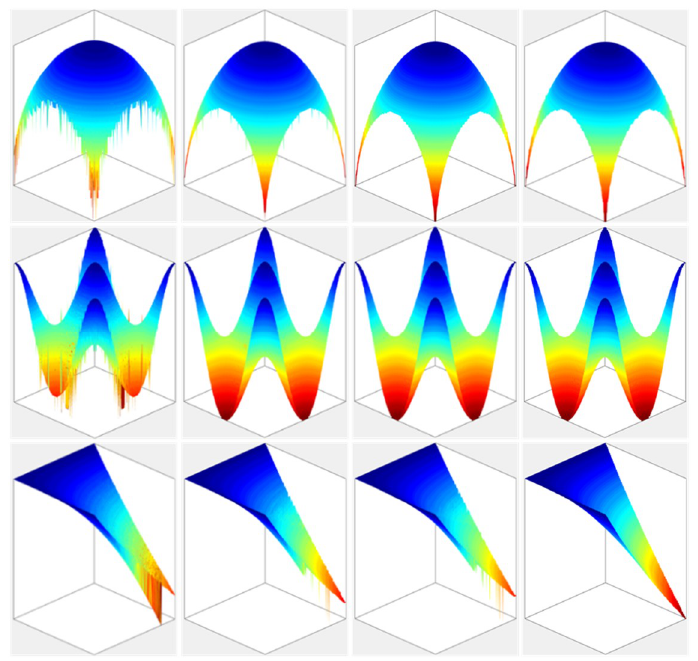
Figure 17. Initial depth map of the three models reconstructed using different evaluation windows of F GLV.